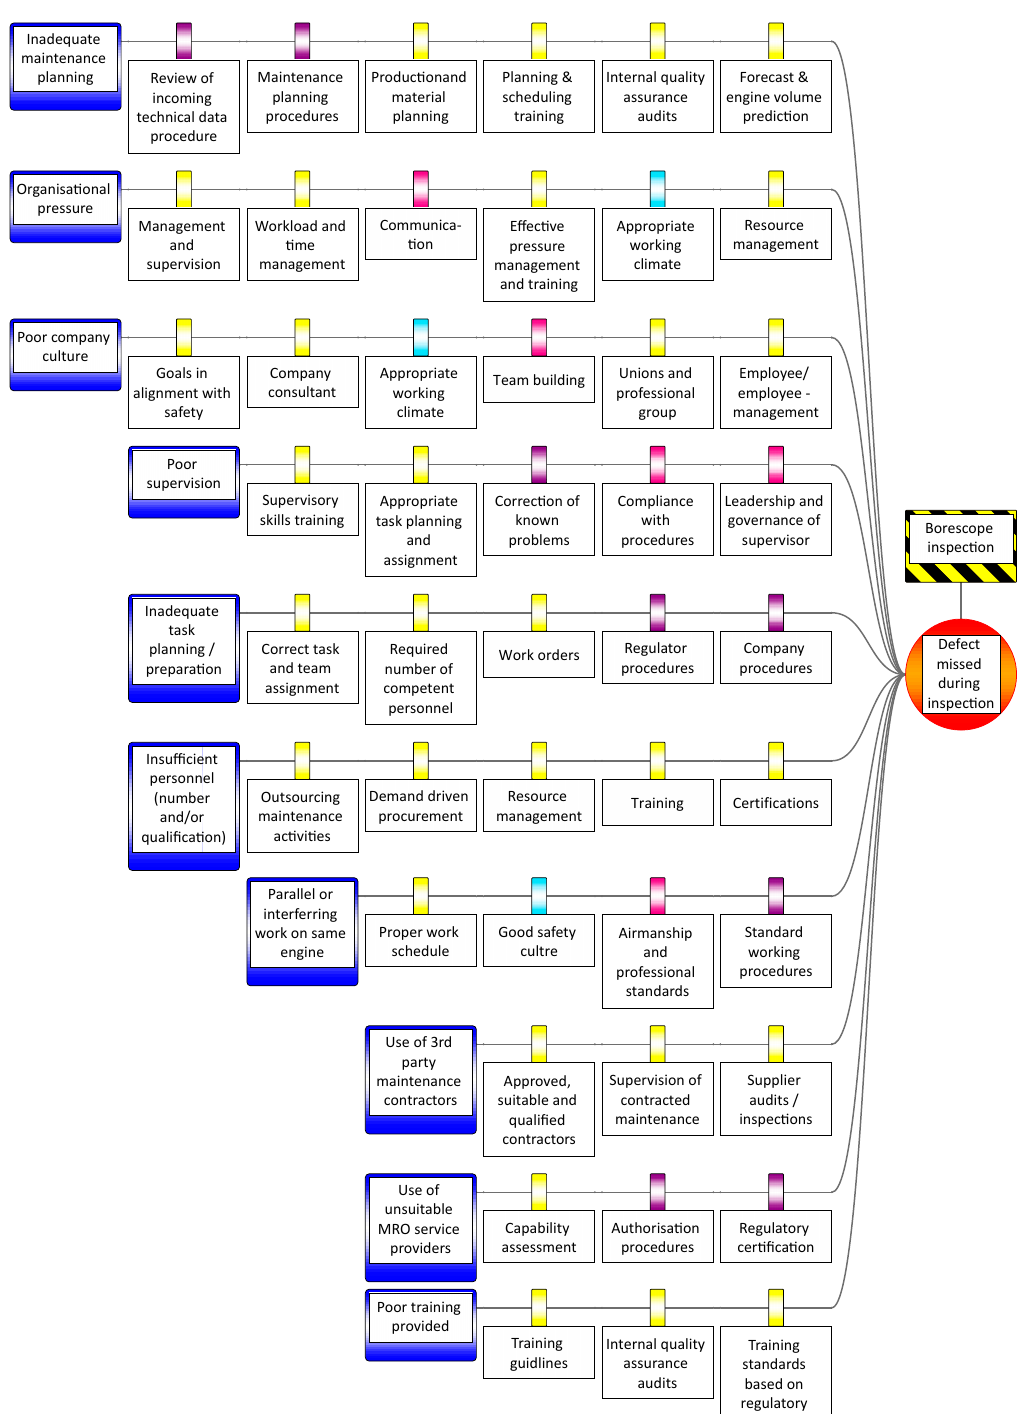
Figure 13. Management-related threat paths with barriers.